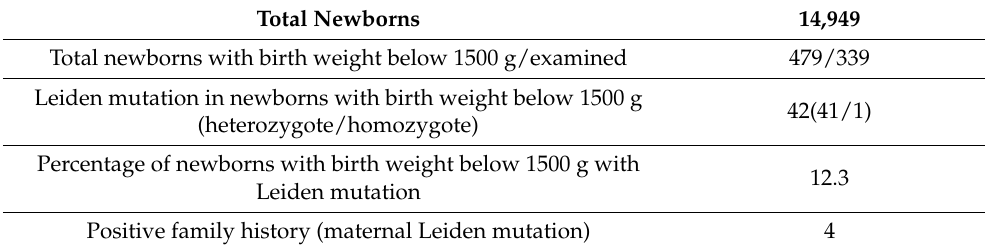
Table 1. Leiden mutation test